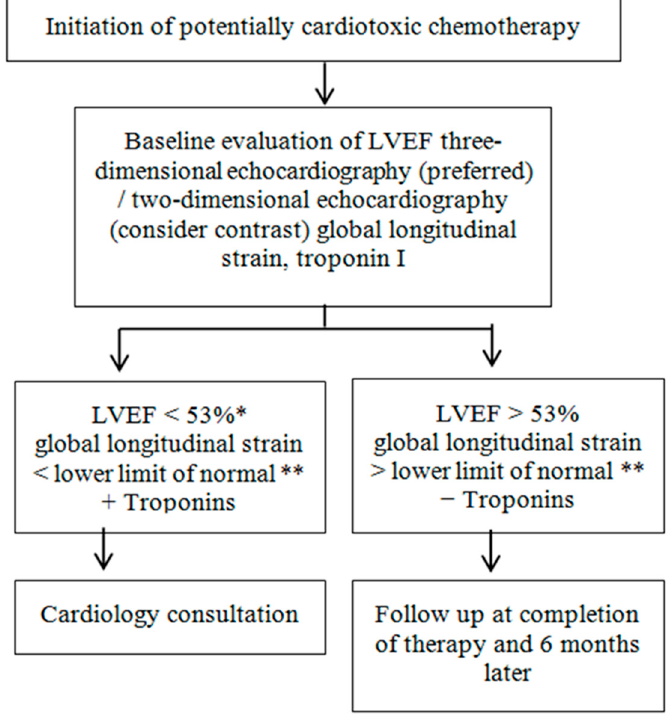
Figure 2. Evaluation of echocardiographic indices and biomarkers in cancer patients prior to the initiation of chemotherapy and proposed follow-up protocols. * Consider confirmation with cardiac magnetic resonance. ** Refer to the American Society of Echocardiography guideline for normal global longitudinal strain values based on vendor, gender, and age. Modified from Expert Consensus for Multi-Modality Imaging Evaluation of Adult Patients During and After Cancer Therapy.